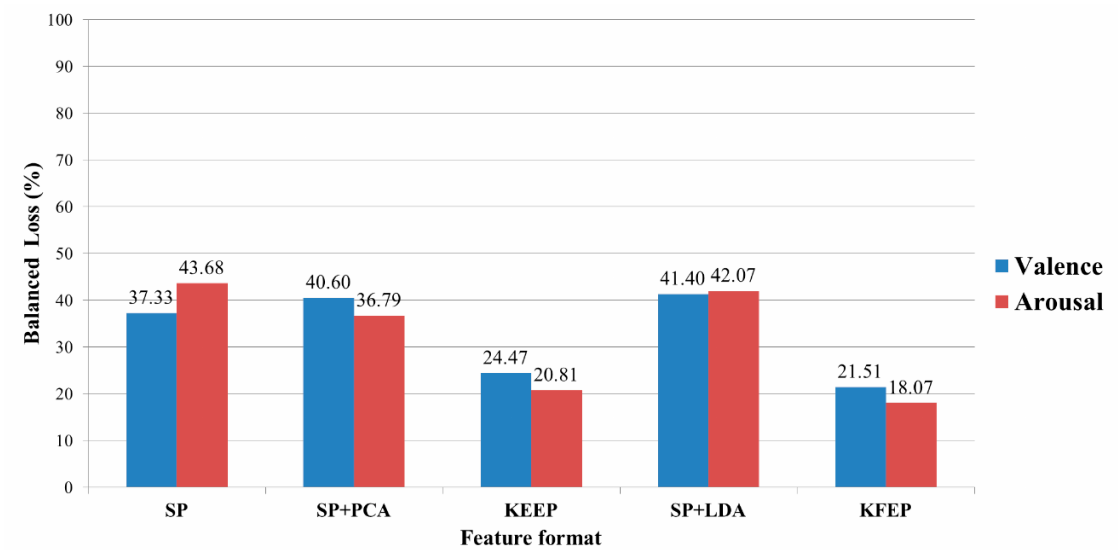
Figure 6. Average error rates of the 10 participants for different features using k -NN